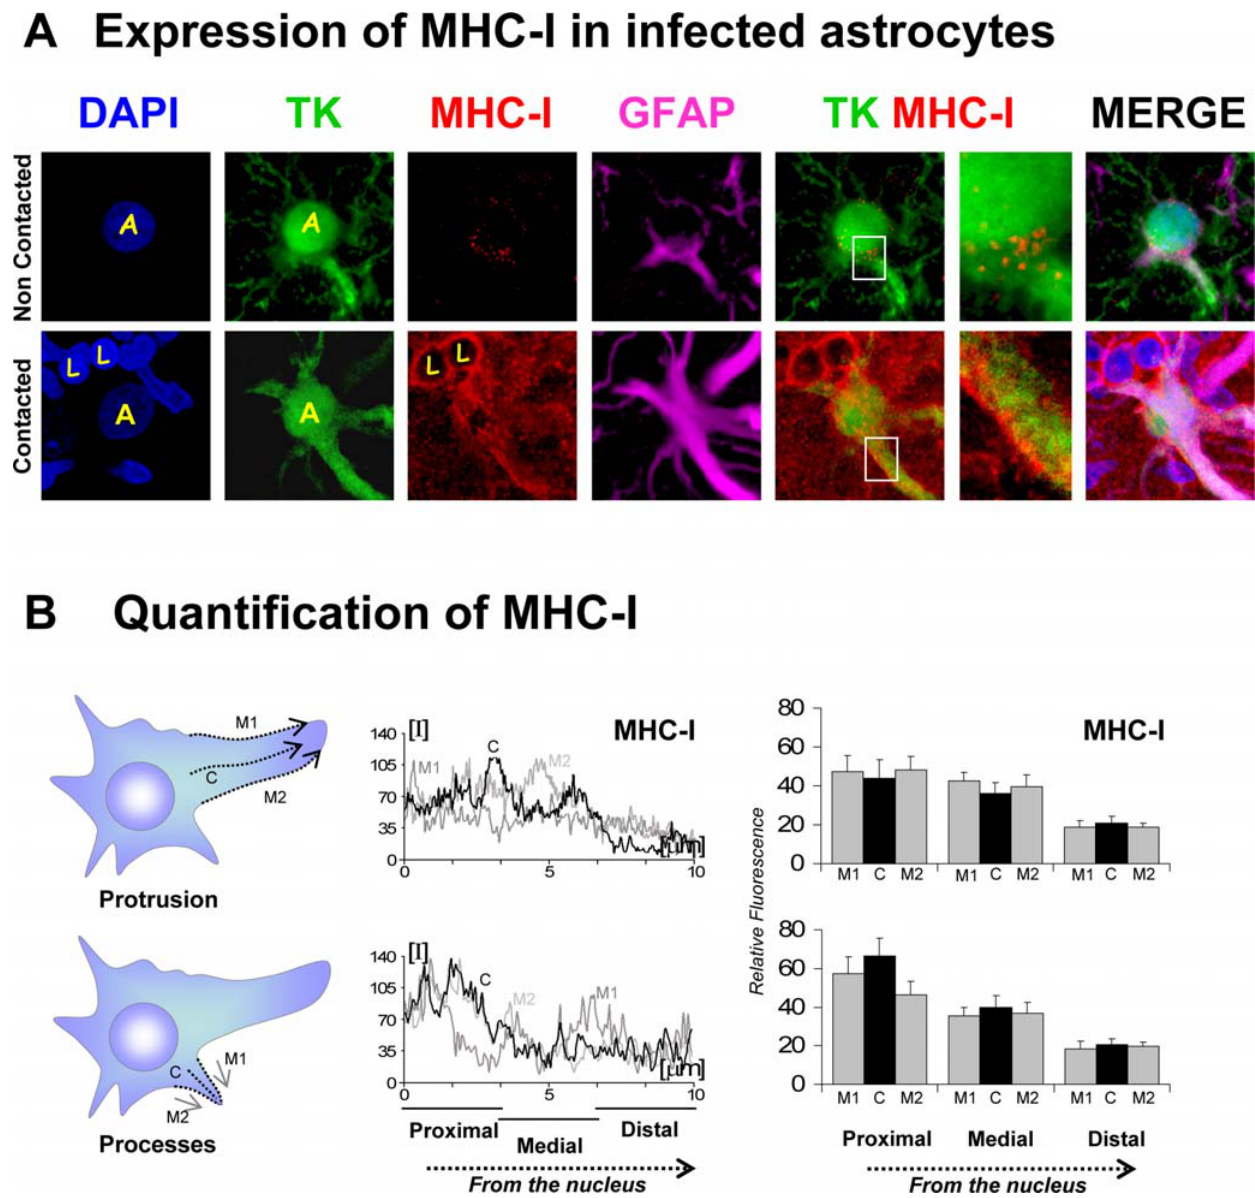
Figure 9. MHC-I expression increases in infected astrocytes during an antiviral immune response, but does not show any particular pattern of distribution in relation to T cells ’ contacts. (A) shows representative confocal images of non-contacted (top row) and contacted cells (bottom row) stained with DAPI (blue), and immunolabeled with markers of viral infection (TK, green), MHC-I (red), and activated astrocytes (GFAP, magenta). The fourth panel in each row shows an overlapping image of TK and MHC-I (TK MHC-1), of which the fifth panel is a higher magnification of the white boxed area. The last panel is a superposition of all four color channels (MERGE). MHC-I is expressed at high levels in virally infected astrocytes in contact with T cells. Note that presumed leukocytes (identified by the absence of TK, or GFAP immunoreactivity, ‘L’ ) display intense MHC-I immunofluorescence. Nuclei of virally infected astrocytes are indicated by (yellow) ‘A’. ( B) shows the relative quantification of MHC-I fluorescence along protrusions (top panels) or processes (bottom panels) of contacted cells. Illustrations on the left indicate the morphological position of the measurements analyzed (with respect to the nucleus). Fluorescence intensity graphs in the center display relative MHC-I immunofluorescence (measured from the cell body to the cell periphery along the arrows indicated in the left panels). MHC-I intensity on both sides (M1 and M2) and cytoplasm (C) of virally infected cells is shown. Analysis of relative fluorescence on the right shows the average intensity of MHC-I expression in proximal, medial and distal areas, relative to the nucleus. The fluorescence intensity of 30 cells was measured. The expression of MHC-I follows a proximo-distal pattern of intensity. doi:10.1371/journal.pone.0002977.g009 induce the target astrocytes to polarize towards the contacting T previously published models of brain injury, we show evidence that cell. Thus, the capacity of T cells to induce polarization of target the morphological changes by which astrocytes respond to an cells may be a general phenomenon. This is supported by previous immune attack are distinct and represent a novel in vivo (and in vitro ) injury response. A similar response was detected in astrocytes findings showing that during spread of HTLV-1 from an infected to a naı¨ve CD4 + T cell, the virus induces polarization of the in contact with allogeneic T cells, suggesting that the T cells may